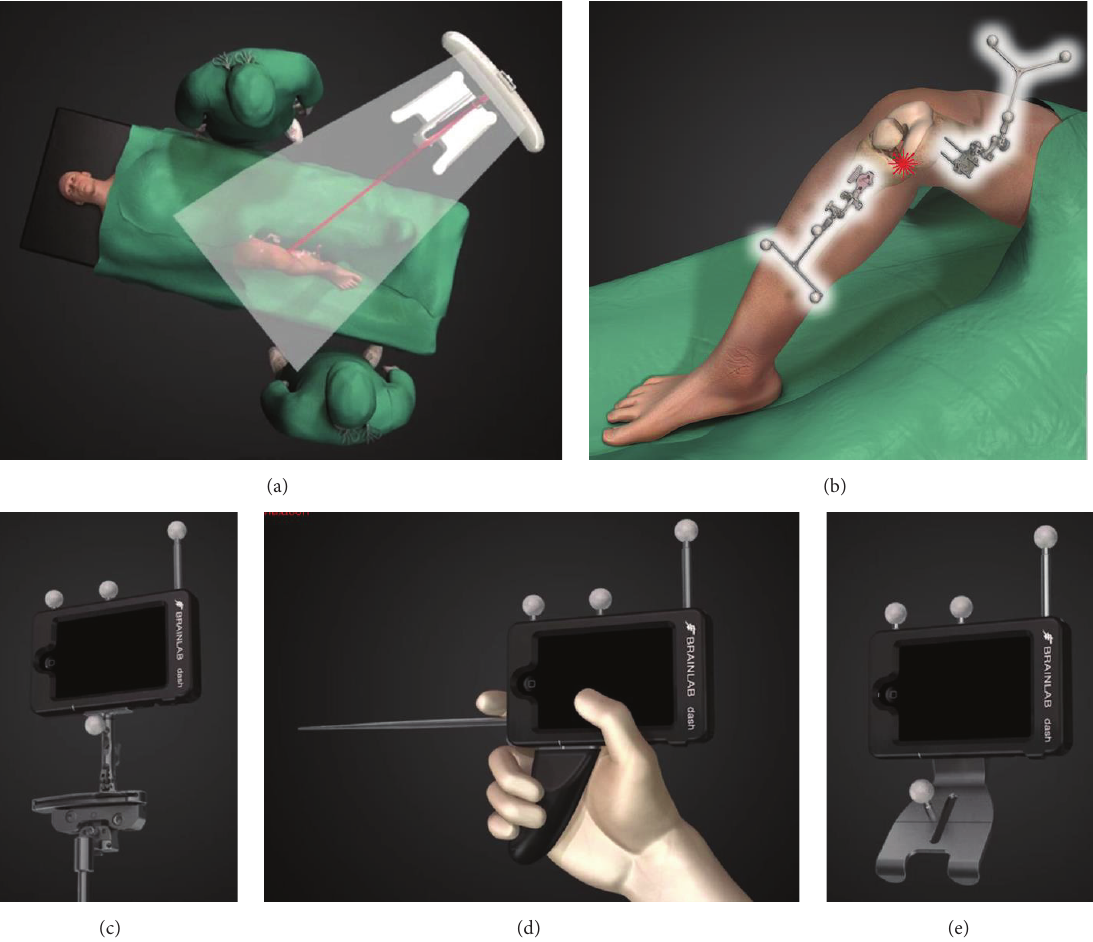
Figure1:(a)Intraoperativesetting.(b)Referencearraysattachedtofemurandtibia.(c)Thecradleisattachedtothecuttingblockforproximal tibial resection. (d) Digitalisation of anatomical landmarks performed using the pointer attached to the handheld cradle. (e) Digitalisation of distal femur anatomy is performed using a special digitalisation tool attached to the